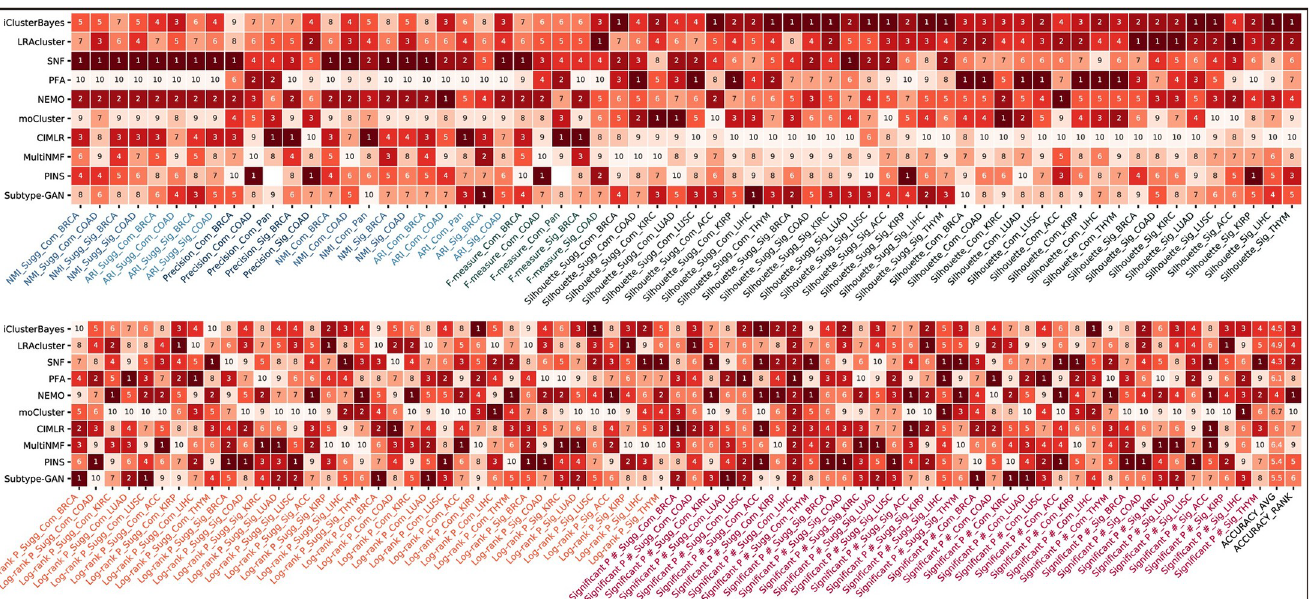
Fig 5. Clustering-based performance of Dataset group #3 Gold Standard Datasets. For each metric (i.e. precision, NMI, ARI, and F-measure) and each integration method, each data point in a box is a measurement of using one of the 11 data type combinations for both BRCA and COAD datasets, and the white line within the box indicates the mean value of the results. (A) Clustering-based performance of gold standard datasets based on the suggested k of methods. We set k -max as 8 and let each method suggest the best k . The performance of the method suggested k was used to evaluate and compared. To the three methods that cannot suggest best k , we clustered BRCA and COAD samples into 5 and 4 clusters, respectively. (B) Clustering-based performance of gold standard datasets based on the pre-defined k . As the true labels of samples and the number of clusters are known in Dataset group #3, we clustered BRCA and COAD samples into 5 and 4 clusters, respectively, and calculated the clustering-based metrics to evaluate and compare the performance of the integration methods.